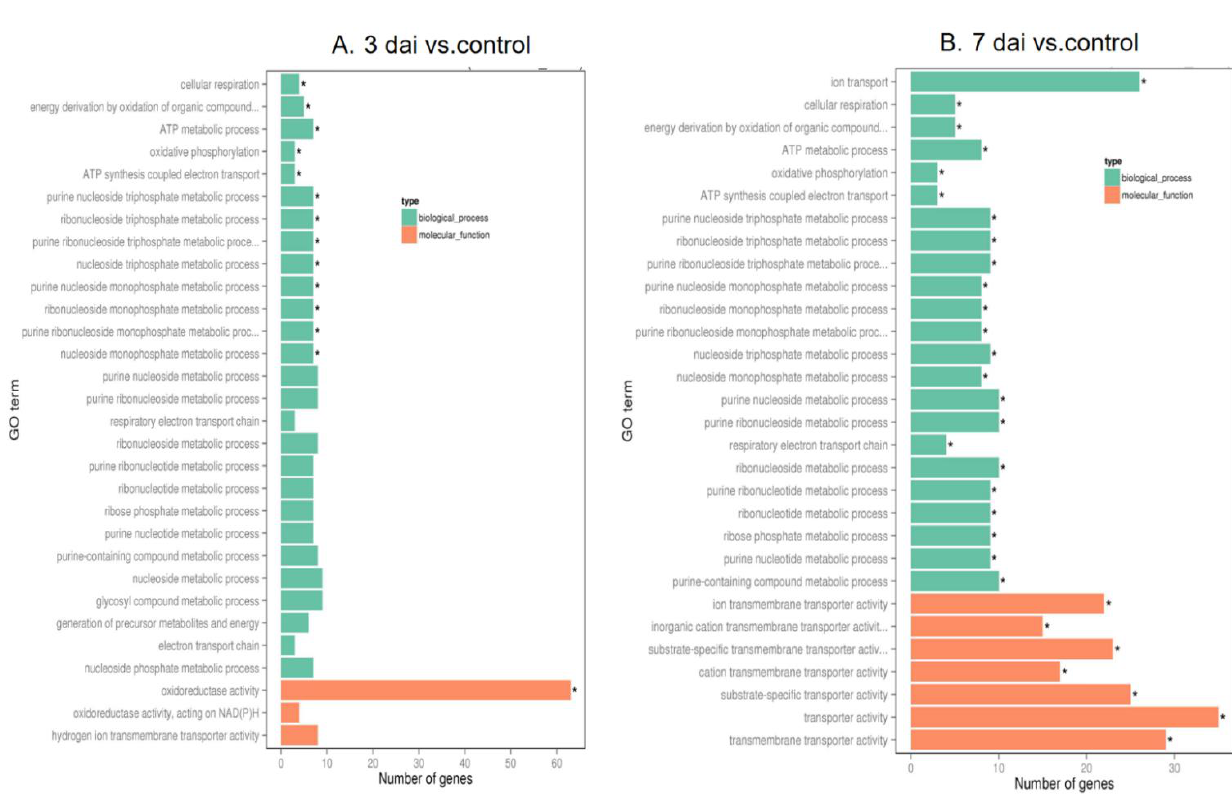
Figure 4. Go enrichment histogram of differentially expressed genes (DEGs) in P. indica . ( A ) GO enrichment in 3 days vs. control; ( B ) GO enrichment in 7 days vs. control. The abscissa denotes the name of GO entry, which is divided into three categories by box: BP: biological process, CC: cell component, MF: molecular function, distinguished by different frames, and the ordinate is the number of genes enriched by GO entry. The significance threshold for p values, corrected for multiple testing (Benjamini–Hochberg) was set at 0.05 (* ≤ 0.05). Table 1. Top 20 P. indica differentially expressed genes (DEGs) during colonization (3 dai vs. con- Table 2. Top 20 P. indica differentially expressed genes (DEGs) during colonization (7 dai vs. control). trol).